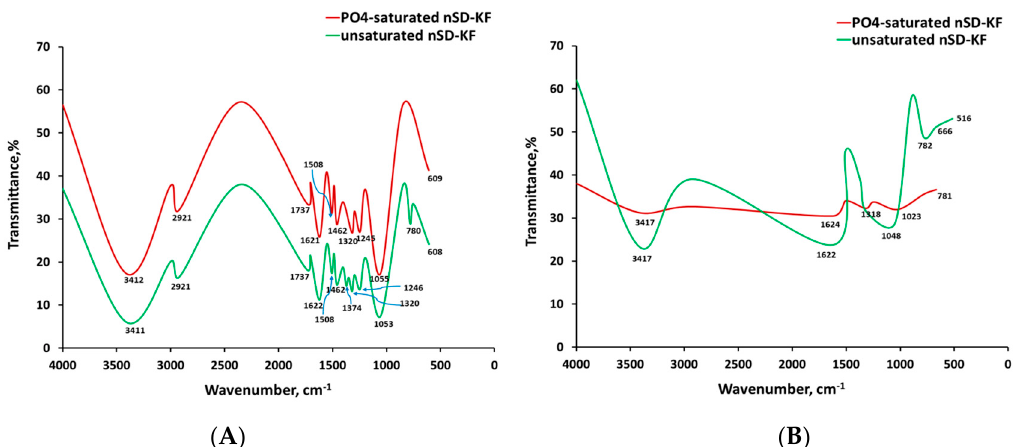
Figure 9. Fourier transmission infrared (FTIR) spectra of nSD-KF and phosphate-loaded nSD-KF before ( A ) and after ( B ) hot-water extraction of chemical constituents.